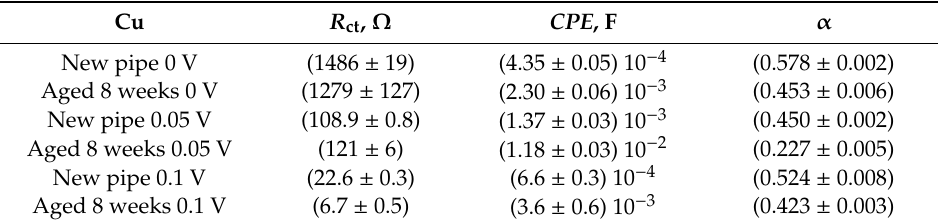
Table 4. R ct for Cu of new pipes and of pipes aged 8